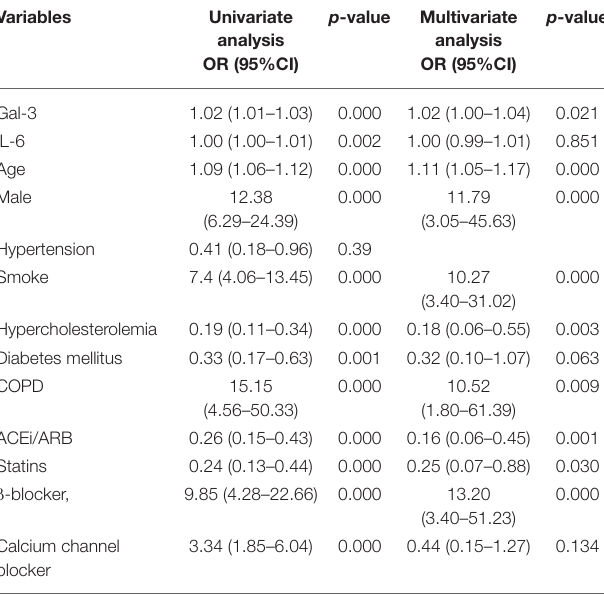
TABLE 2 | Logistic regression analysis of Gal-3 for the presence of AAA.